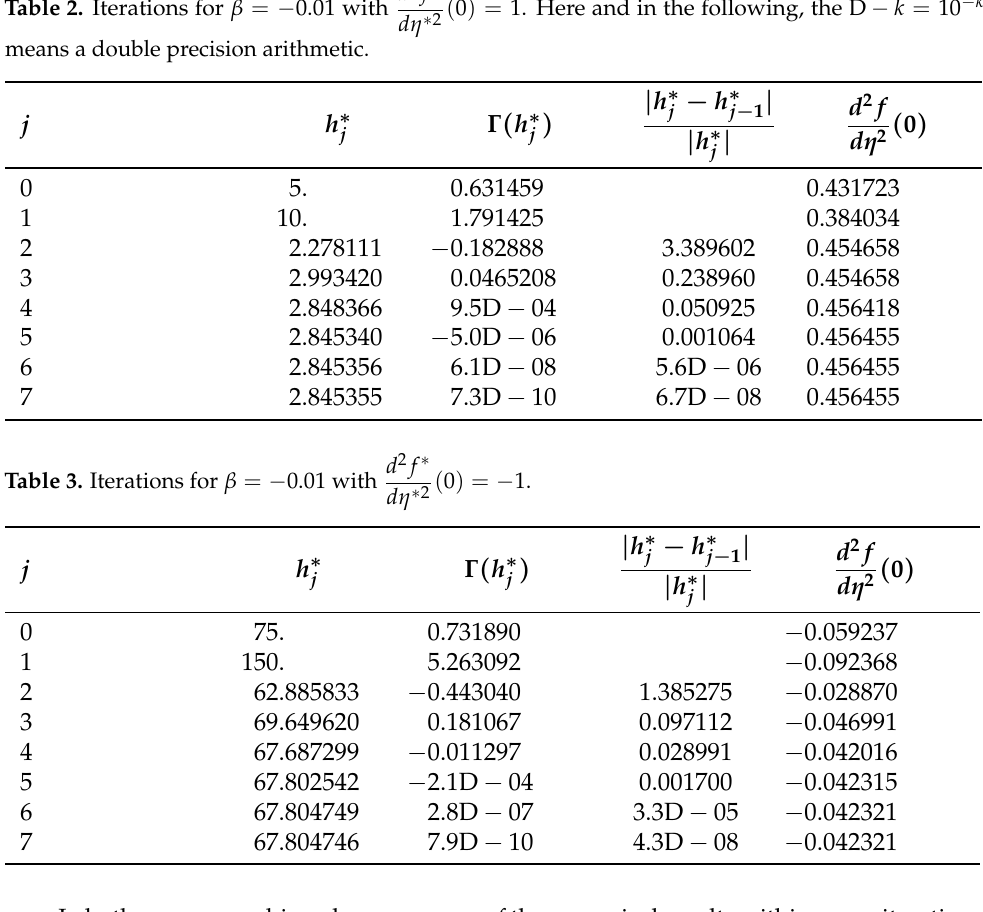
d 2 f ∗ ( 0 ) = 1. Here and in the following, the D − k = 10 − k d η ∗ 2